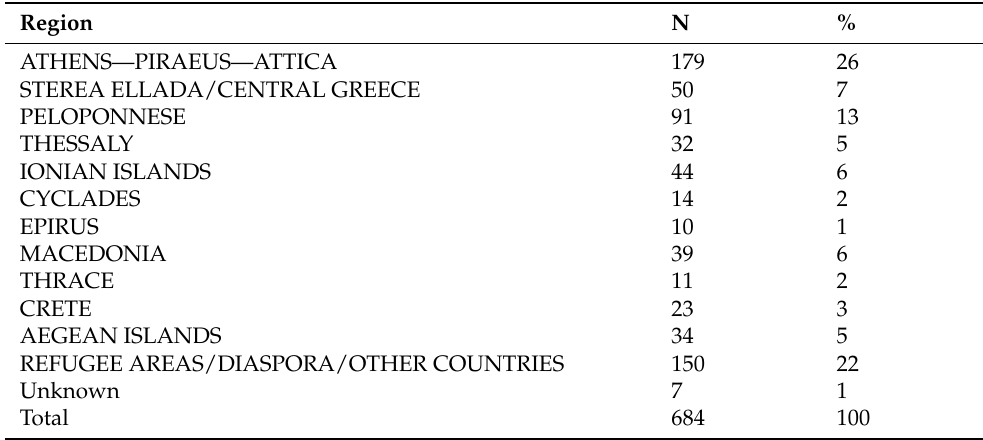
Table 1. Place of origin of female graduates from the School of Medicine,